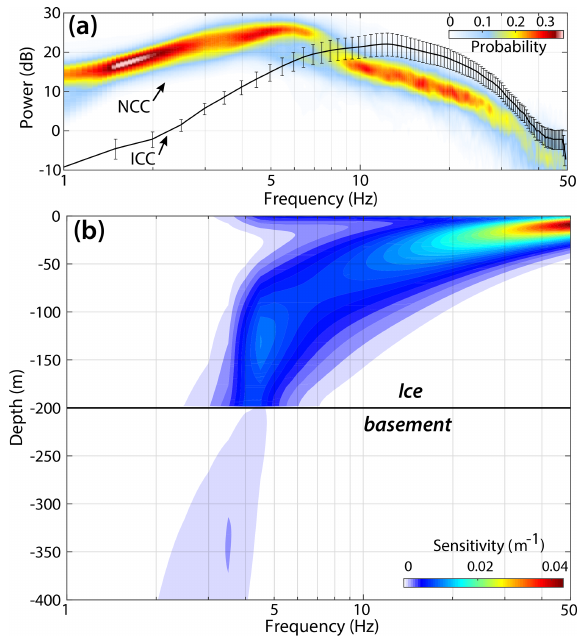
Figure 4. (a) Probability density function of noise cross-correlation (NCC) spectra (colors) and median average of icequake cross- correlation (ICC) spectra (black line). Note that raw data (i.e con- tinuous noise or icequake waveforms) were spectrally whitened be- tween 1 and 50Hz prior to cross-correlation. Due to spectral content of englacial noise and icequakes, NCCs and ICCs have different depth sensitivity due to spectral response. (b) Vertical sensitivity kernels for phase velocities of the Rayleigh wave a fundamental mode for an ice thickness of 200m over a semi-half-space repre- senting the bedrock. The kernels were computed using the freely available code of Haney and Tsai